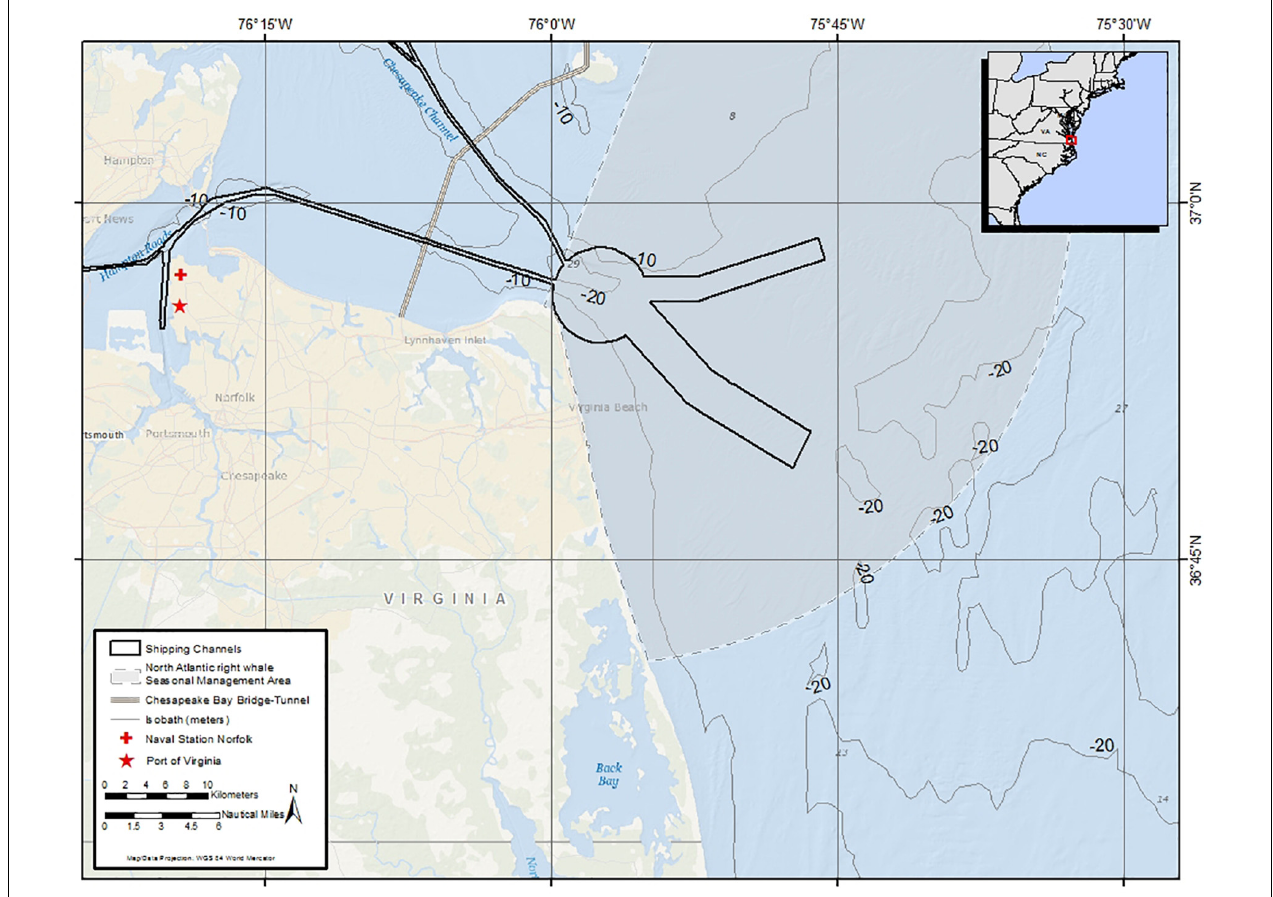
FIGURE 1 | Map of the primary study area, which includes waters in and around the mouth of the Chesapeake Bay off Virginia Beach, Virginia as well as the Port of Virginia and Naval Station Norfolk. Shipping channels are outlined in black and the North Atlantic right whale Seasonal Management Area is shaded. The 37-km Chesapeake Bay Bridge-Tunnel spanning the mouth of the Bay is also